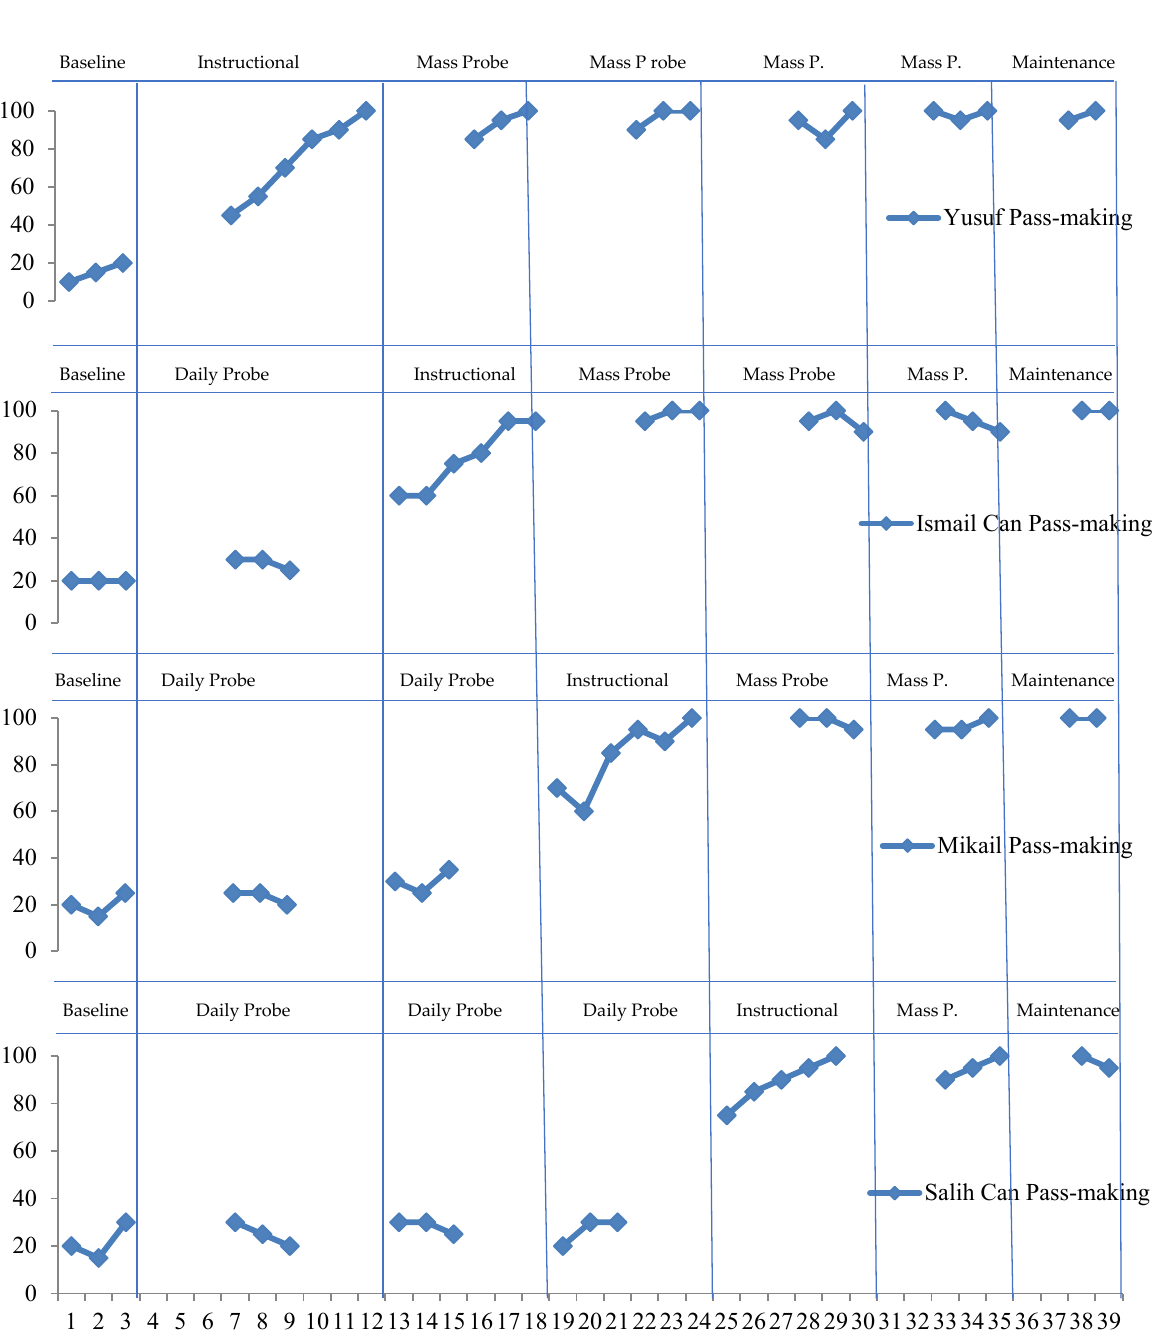
Figure 2. Data on instructional the ability to pass in basketball.